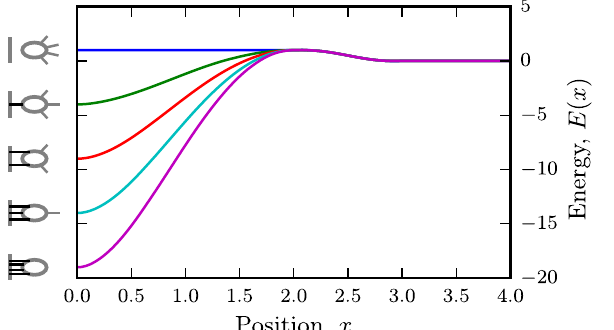
FIG. 10. Energy landscape for the different attachment modes, m ¼ 0 ; 1 ; … ; 4